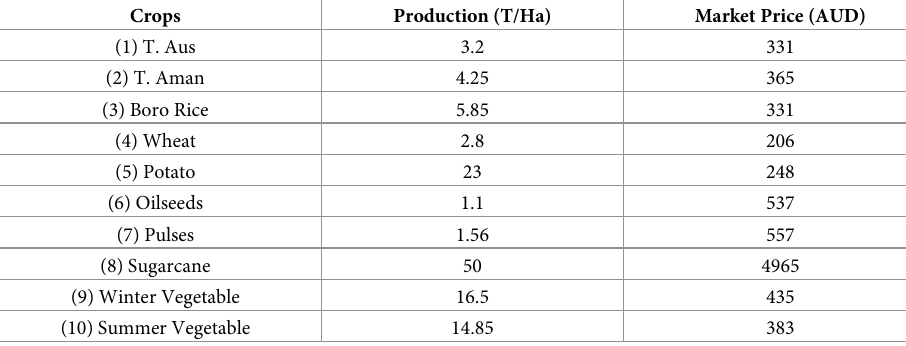
Table 5. Economic data for crops in the Muhuri irrigation area (1 AUD = 60 Taka).